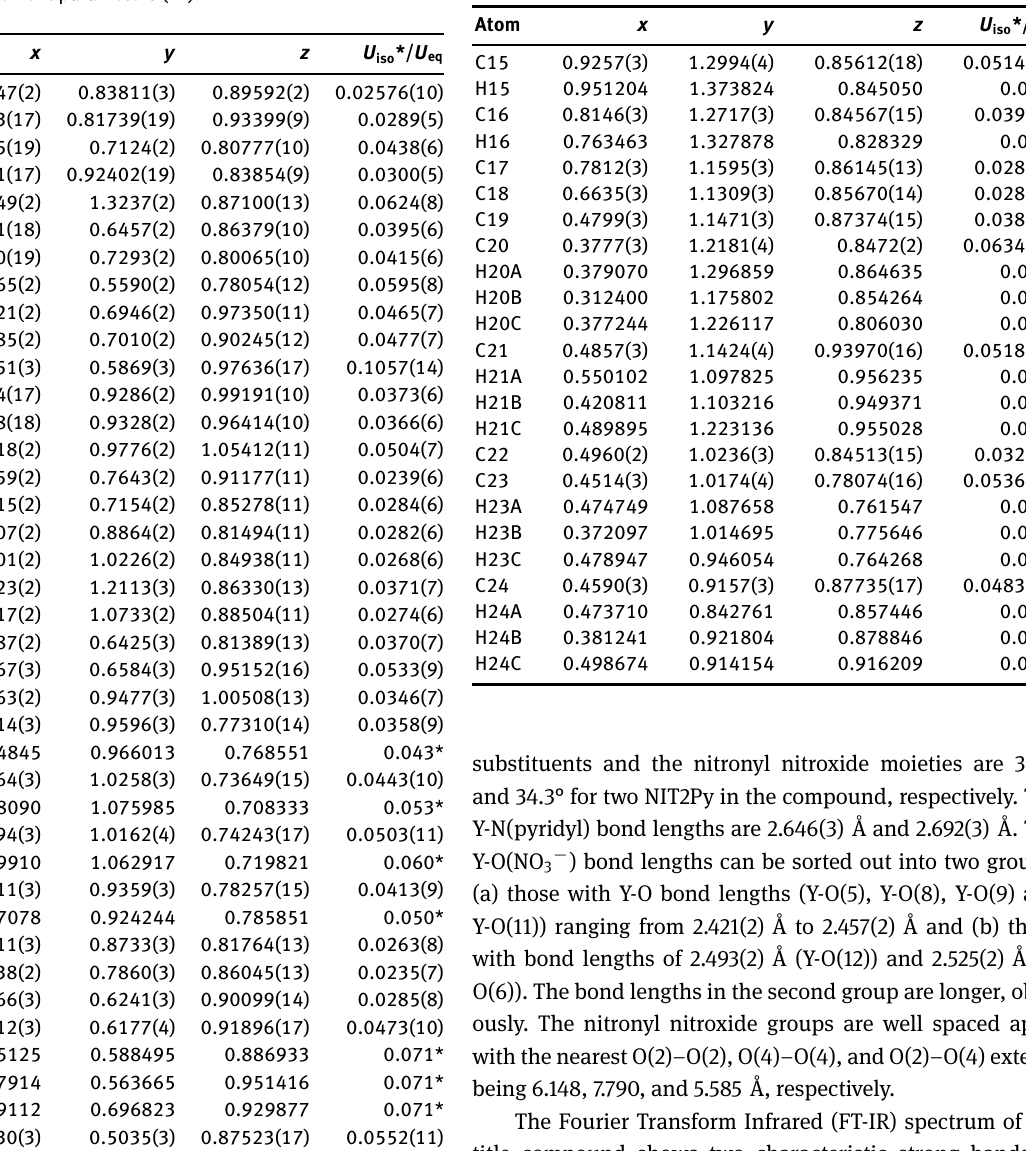
Table 2: Fractional atomic coordinates and isotropic or equivalent isotropic displacement parameters (Å 2